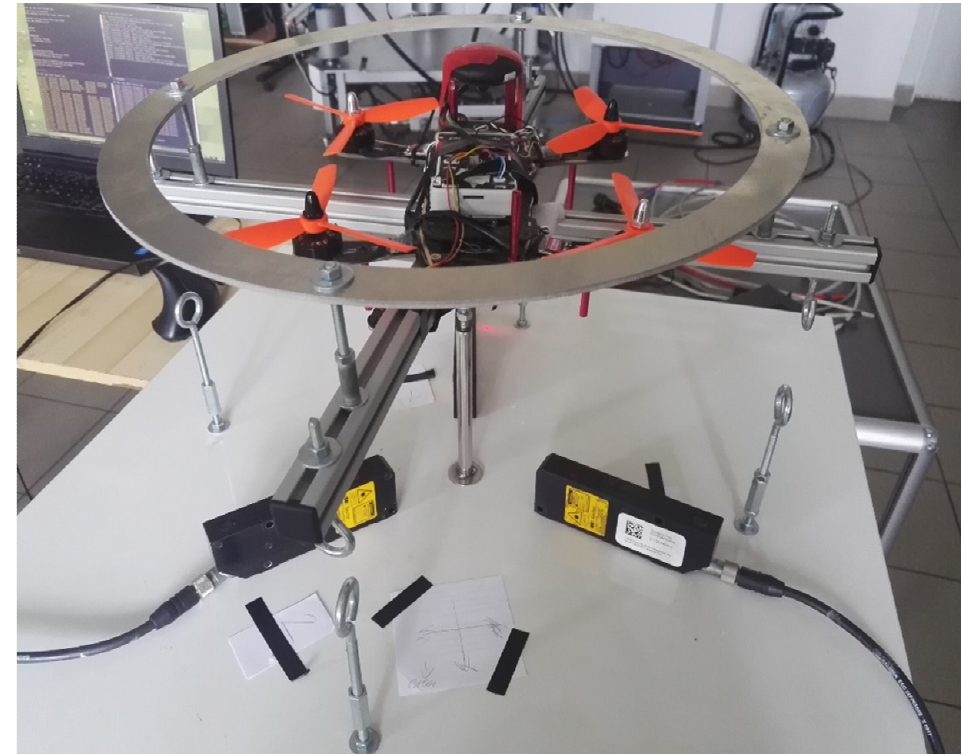
Figure 4. Drone mounted on the test-bench.